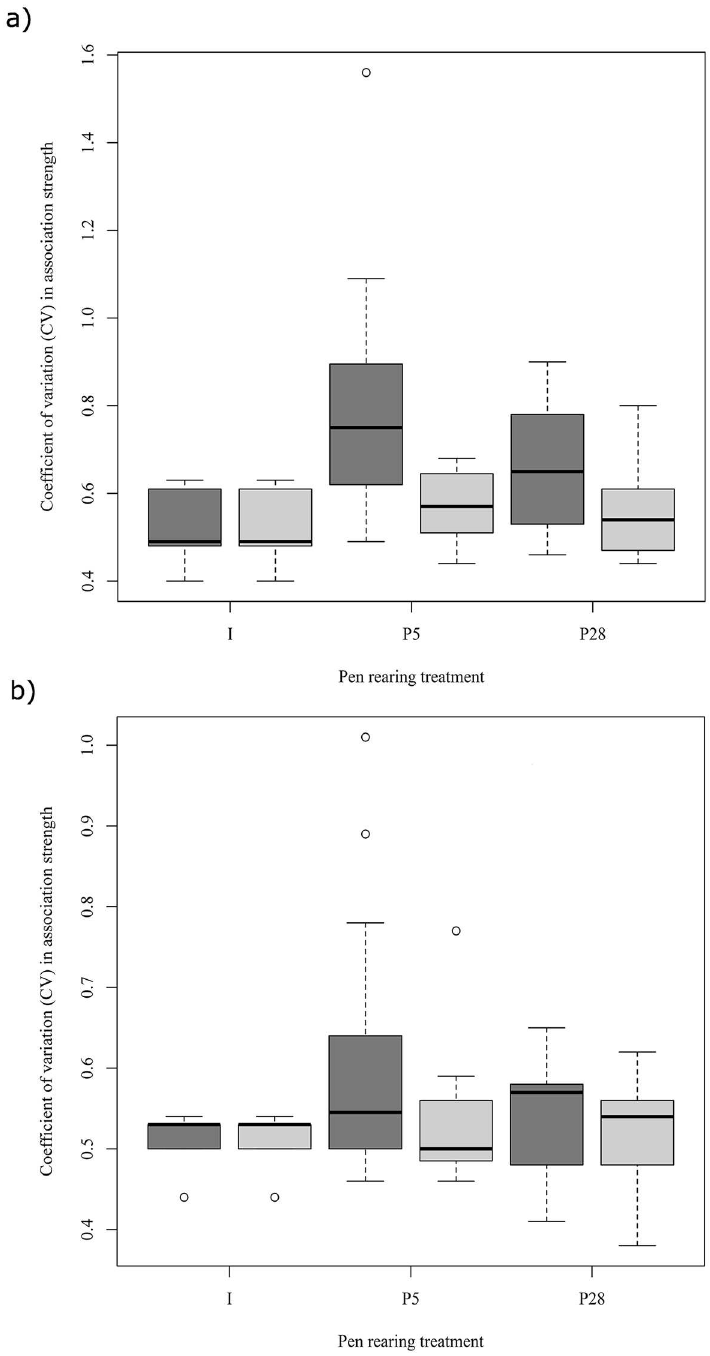
Fig 2. Heterogeneity of social interactions. The coefficientof variation(CV) in associationstrength for calves in each rearing treatment duringweek one (a) and week four (b). Dark grey boxes show all data; light grey boxes show data when associations betweenpreviouslypairedcalves was